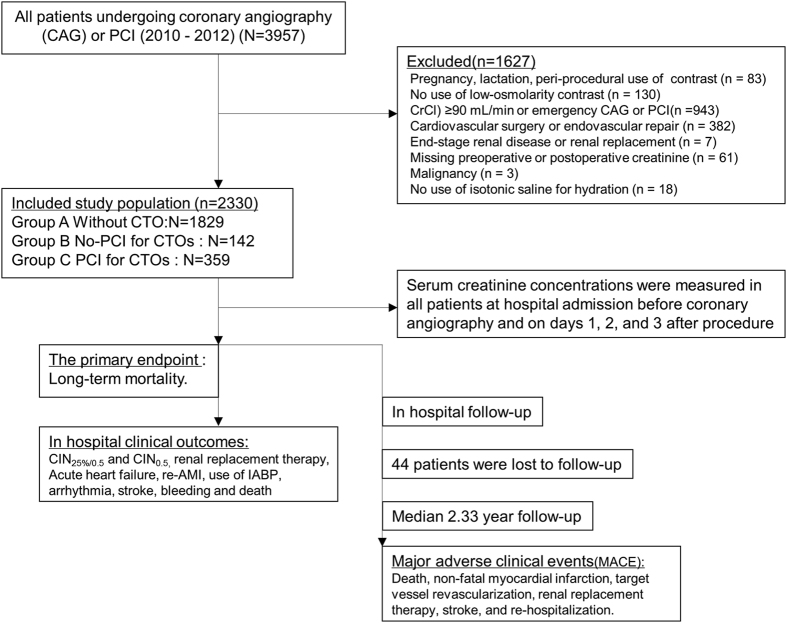
Flow Diagram of Patients with Chronic Kidney Disease Undergoing Coronary Angiography or PCI.A = without CTO; B = un-attempted CTO-PCI; C = attempted CTO-PCI; CI-AKI = contrast-induced acute kidney injury; CIN = contrast-induced nephropathy; CrCl = creatinine clearance; CTO = chronic total occlusion; IABP = intra-aortic balloon pump; PCI = percutaneous coronary intervention; re-AMI = relapse acute myocardial infarction.